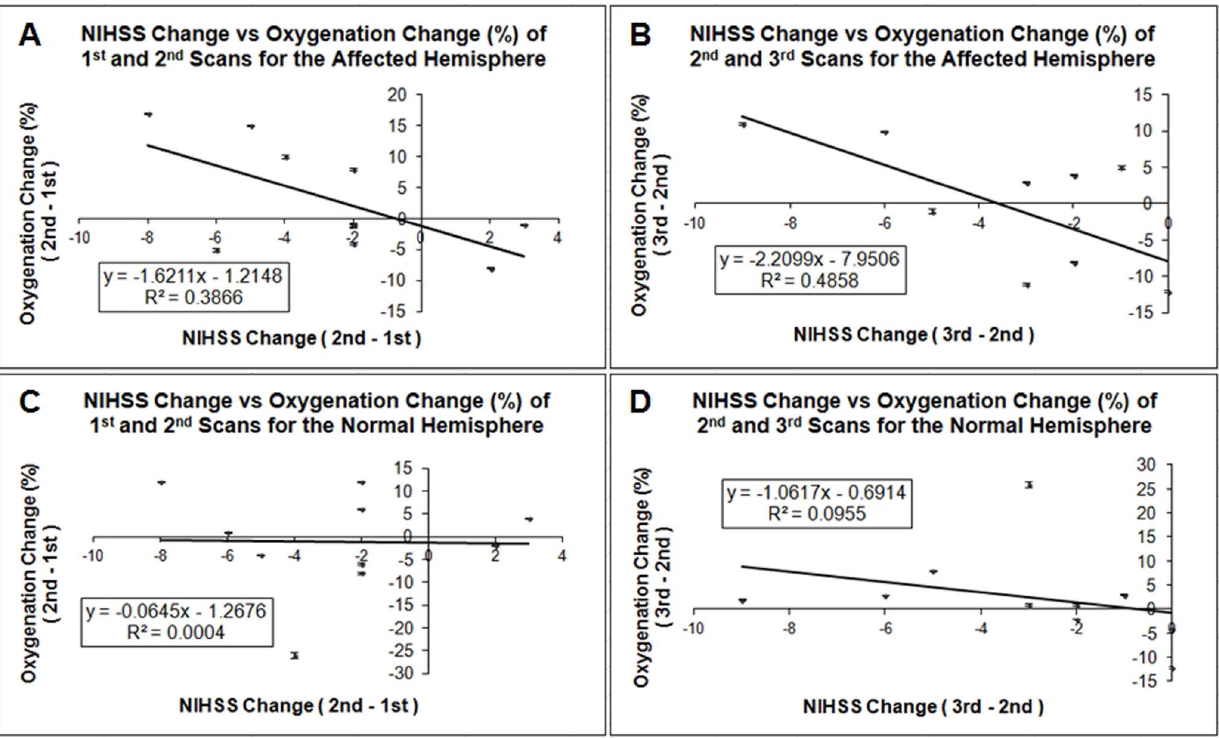
Figure 4. Oxygenation changes vs. NIHSS changes scatter plots with error bar of both hemispheres for ten stroke patients. A) D Y 2,1 vs. D NIHSS2,1 for the stroke hemisphere; B) D Y 3,2 vs. D NIHSS3,2 for the stroke hemisphere; C) D Y 2,1 vs. D NIHSS2,1 for the non-stroke hemisphere; D) D Y 3,2 vs. D NIHSS3,2 for the non-stroke hemisphere. Here D Y 2,1 and D Y 3,2 are the average over 10 vessels for each hemisphere.